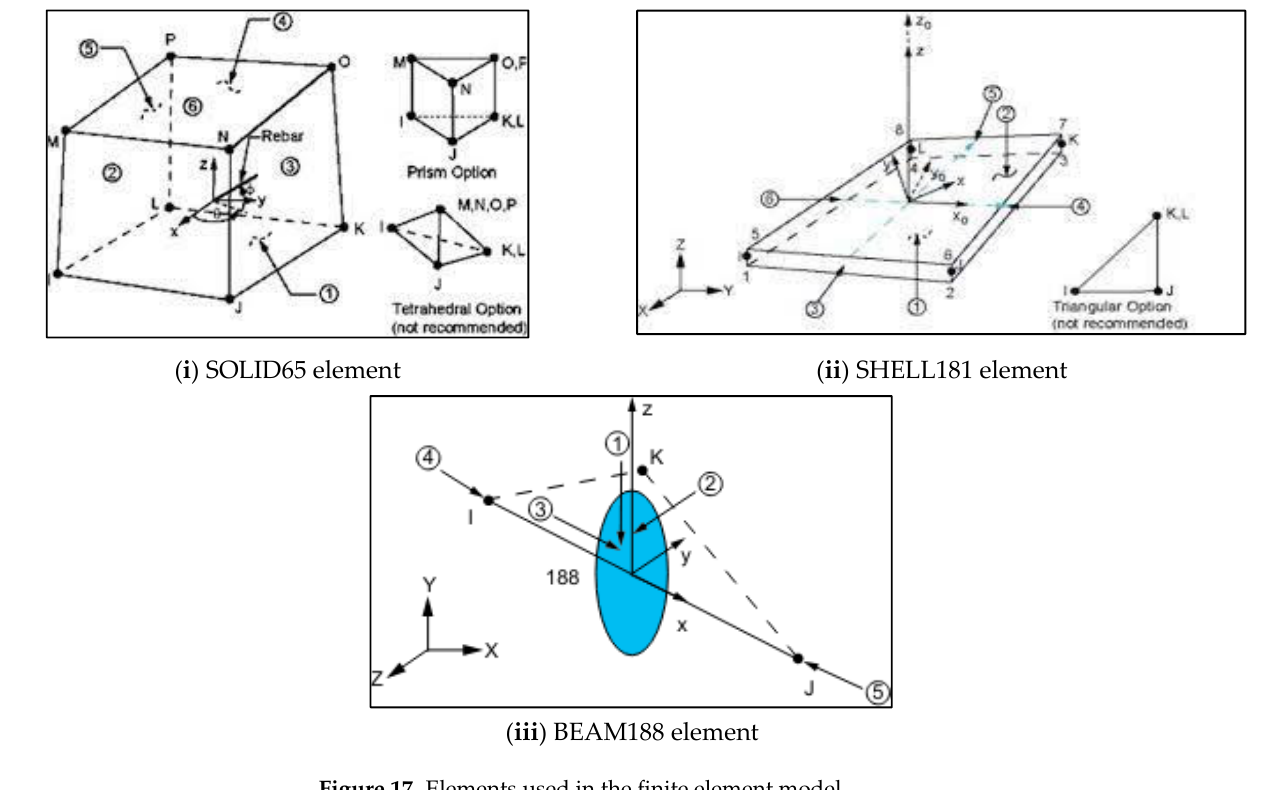
Figure 17. Elements used in the finite element model.